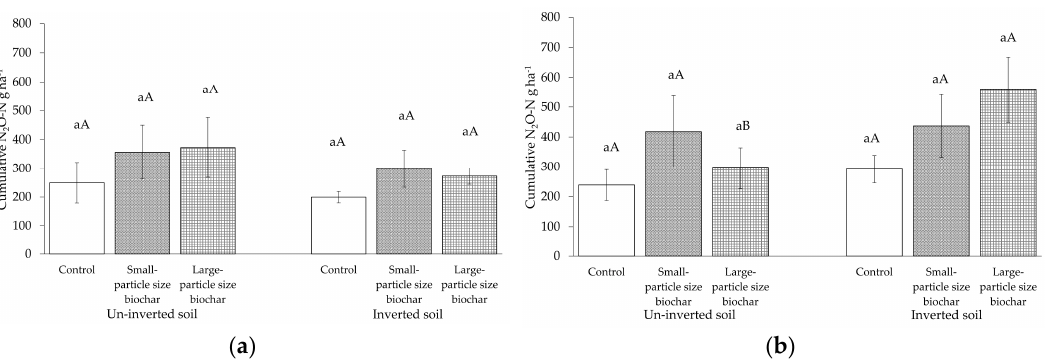
Figure 3. Cumulative N 2 O emissions from soil columns after cattle urine application for summer ( a ) and autumn ( b ) trials. Within a specific season and specific soil inversion treatment, different small letters indicate differences between biochar treatments (SEM (n = 4) and p < 0.10). Within a specific season and specific biochar treatment, different uppercase letters indicate differences between un-inverted and inverted treatments (SEM (n = 4) and p < 0.10).